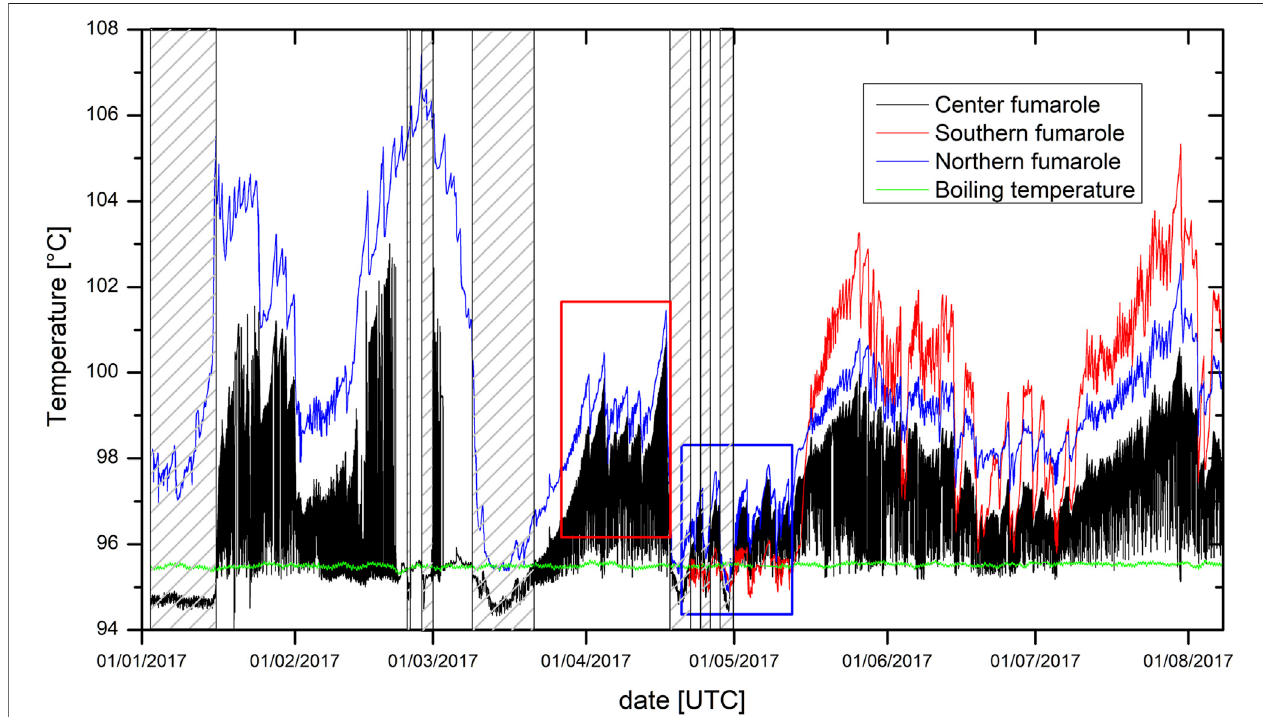
FIGURE 3 | Temperatures in the center, southern and northern fumaroles of the South Crater. Boxes with hatched pattern are when the Center fumarole temperature is below the boiling temperature of water (see part 3.4). Red and blue boxes are “ hot ” and “ cold ” periods of the northern fumarole discussed in part 4.2.